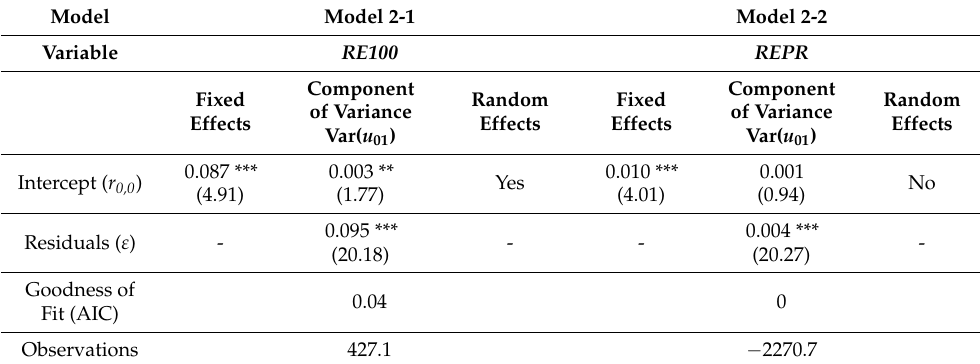
Table 3. The results of null model estimates under the HLM (difference for means between groups).